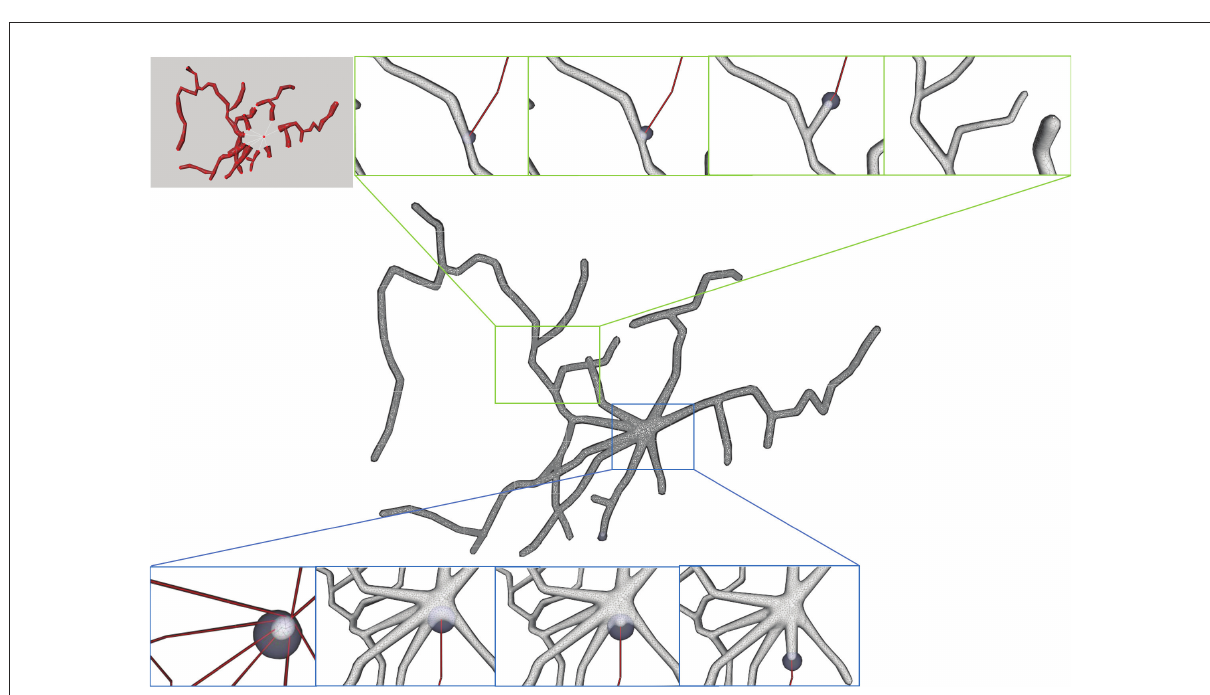
FIGURE14 Progressive surface evolution. The mesh growing processes at a branch (top) and at the root node (bottom) are illustrated for several different